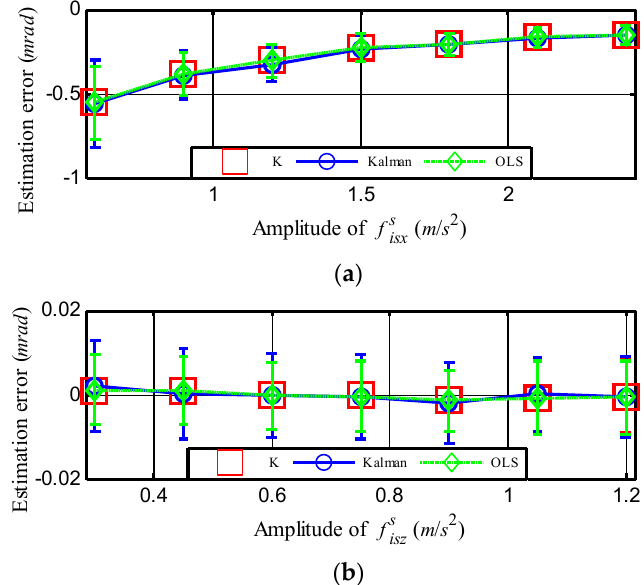
Figure 6. Bias error as a function of the amplitude of acceleration measured by SINS. Error for the estimation of ( a ) yawing angle and ( b ) pitching angle. The vertical lines indicate the corresponding standard deviations or error bars.